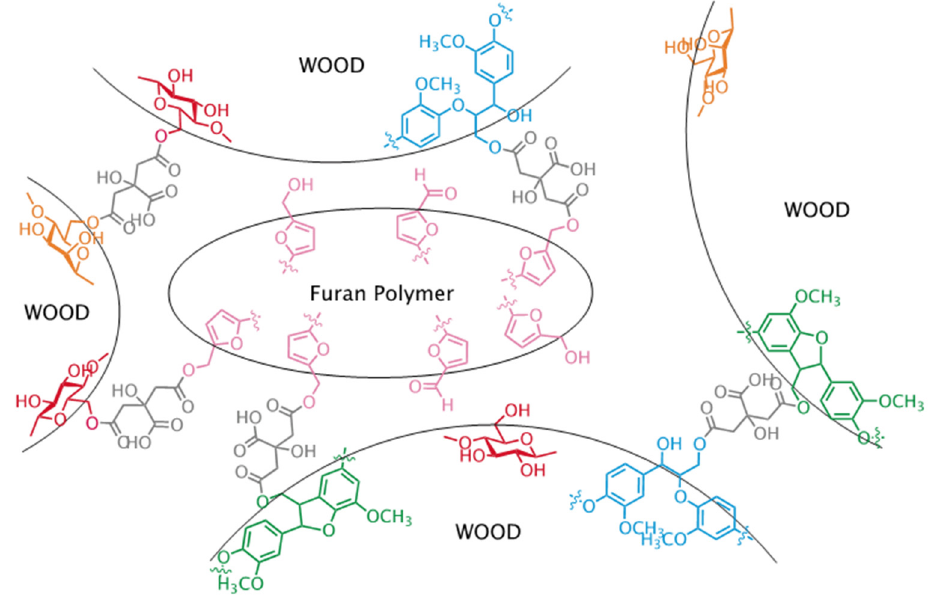
Figure 4. Structures between wood powders.